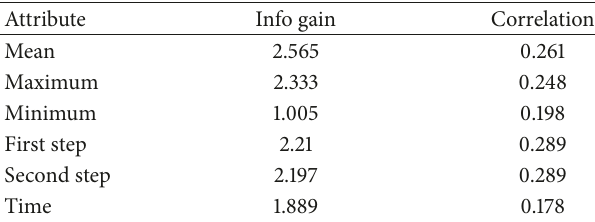
Table 4: Attribute selection results.